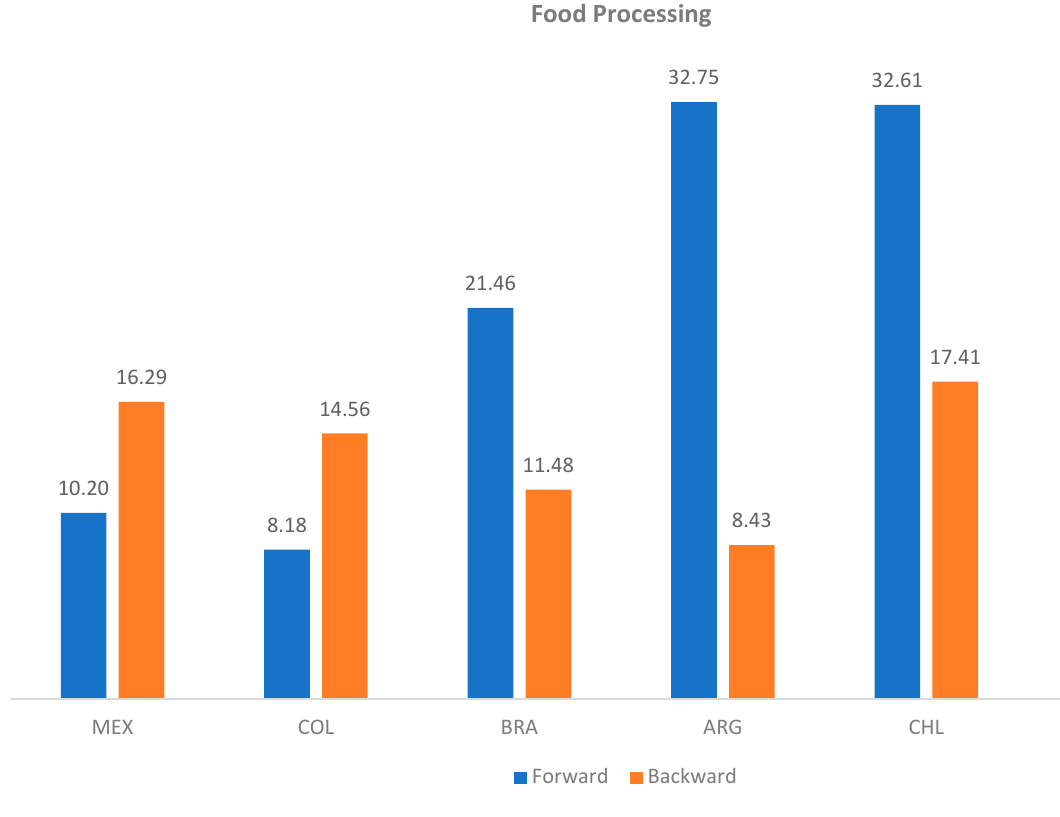
Figure 5. Forward–backward linkage indices for agriculture and the food industry. Source: OECD Economic Surveys: Colombia 2019.